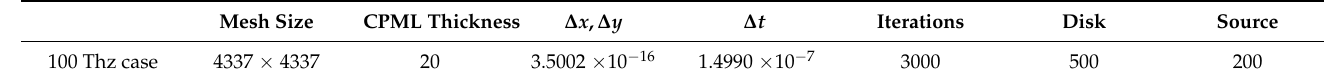
Table 15. Experiments setup for the free open space scenery. Iterations refer to the number of time steps performed. Disk, to the number of iterations when the information has to be transferred to the CPU and saved to the disk. Source, refers to the number of operations when the source is turned off.